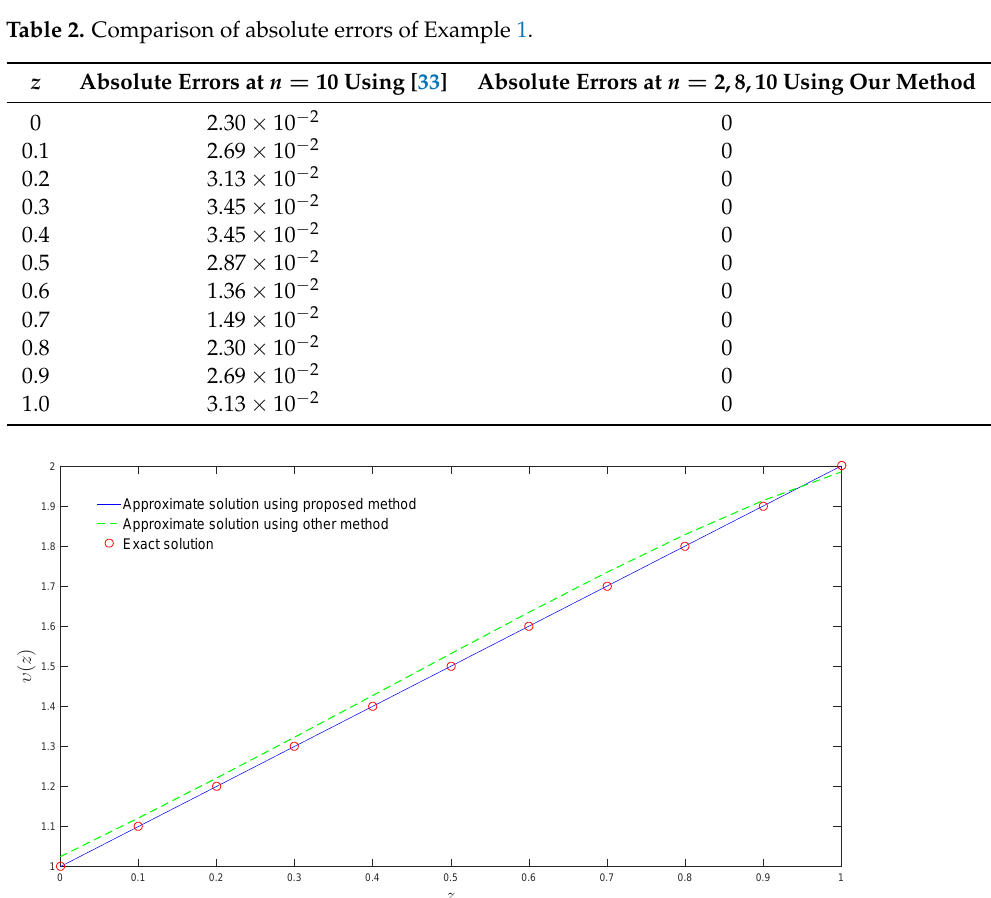
Figure 1. Approximate solutions of Example 1 computed by our method at n = 2 is compared with the method of [33] computed at n =